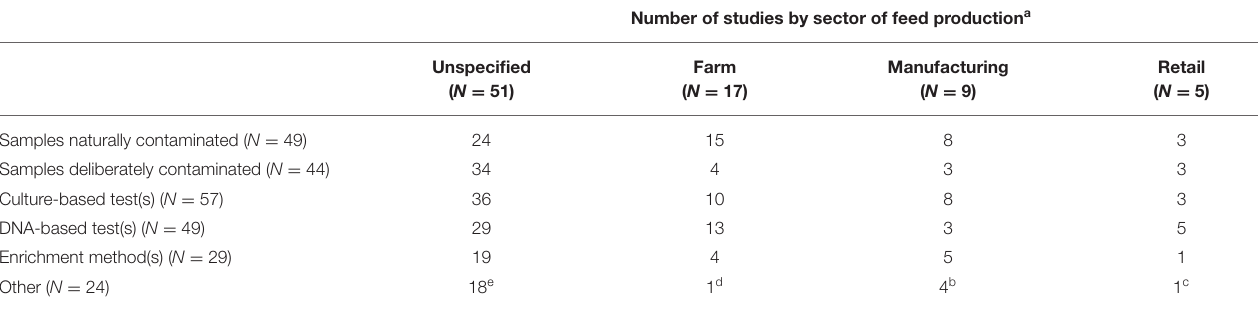
TABLE 7 | Summary of 81 detection-method studies of Salmonella in animal feeds, feed environment and feed equipment across sector of animal feed